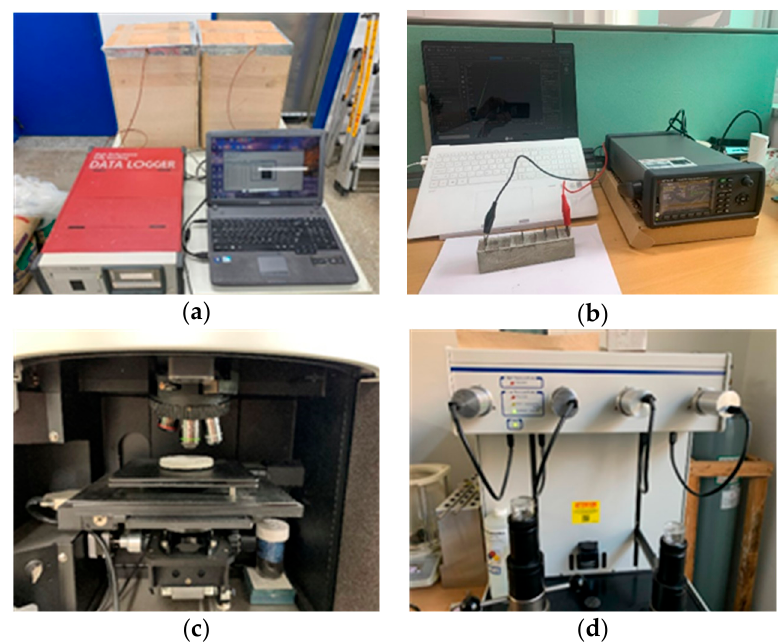
Figure 2. Experiment equipment. ( a ) Heat of hydration; ( b ) electrical resistance; ( c ) Raman spectrophotometer; and ( d ) mercury porosimeter.